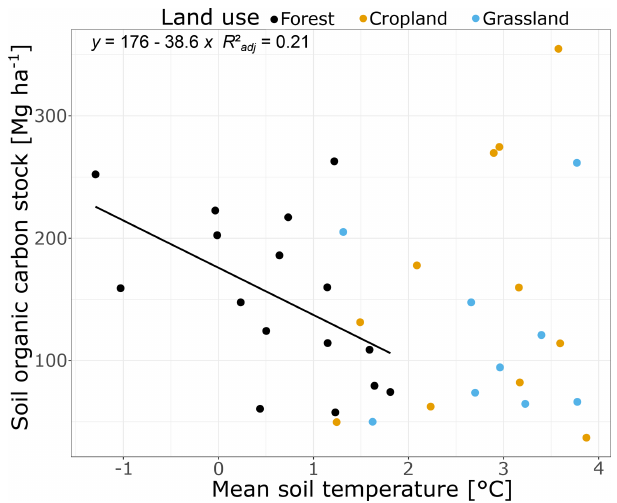
Figure 8. Soil organic carbon (SOC) stocks between 0–80cm depth [Mgha − 1 ] and mean soil temperature [ ◦ C] of forest, grassland and cropland soils with a significant ( p< 0 . 05) correlation (solid line) between SOC stocks and soil temperature in forest soils. Mean tem- perature was calculated from soil temperatures at 10 and